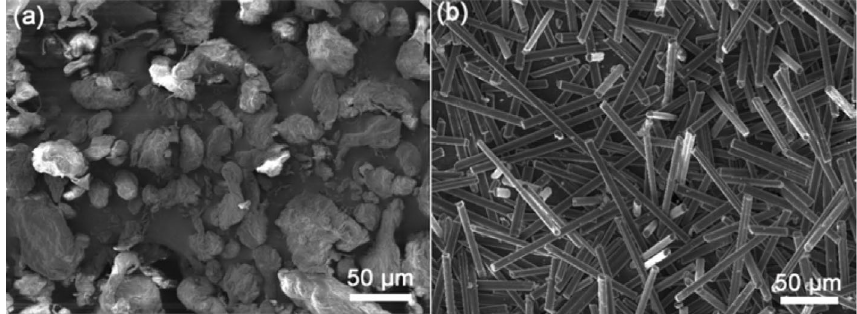
Fig. 1 SEM images of (a) AP and (b) SCF.